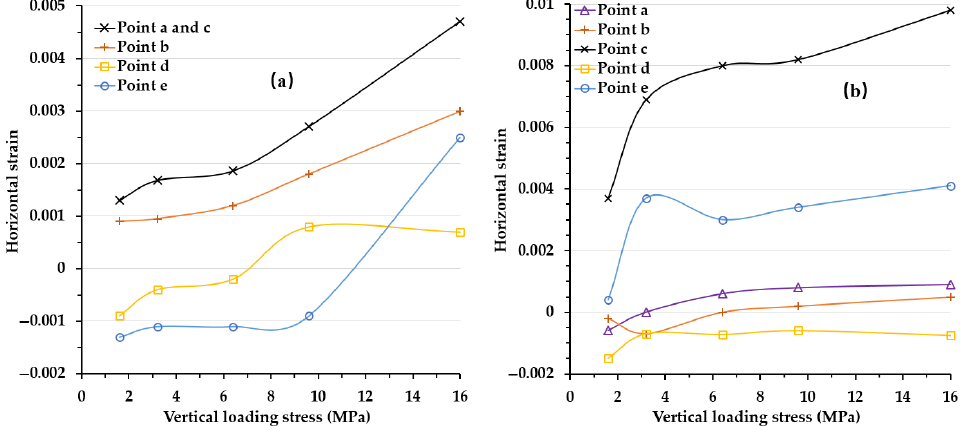
Figure 7. Horizontal strain value of the slope model with no crack. ( a ) Under different loading; ( b ) under different loadings and irrigation with 25 mL/min.